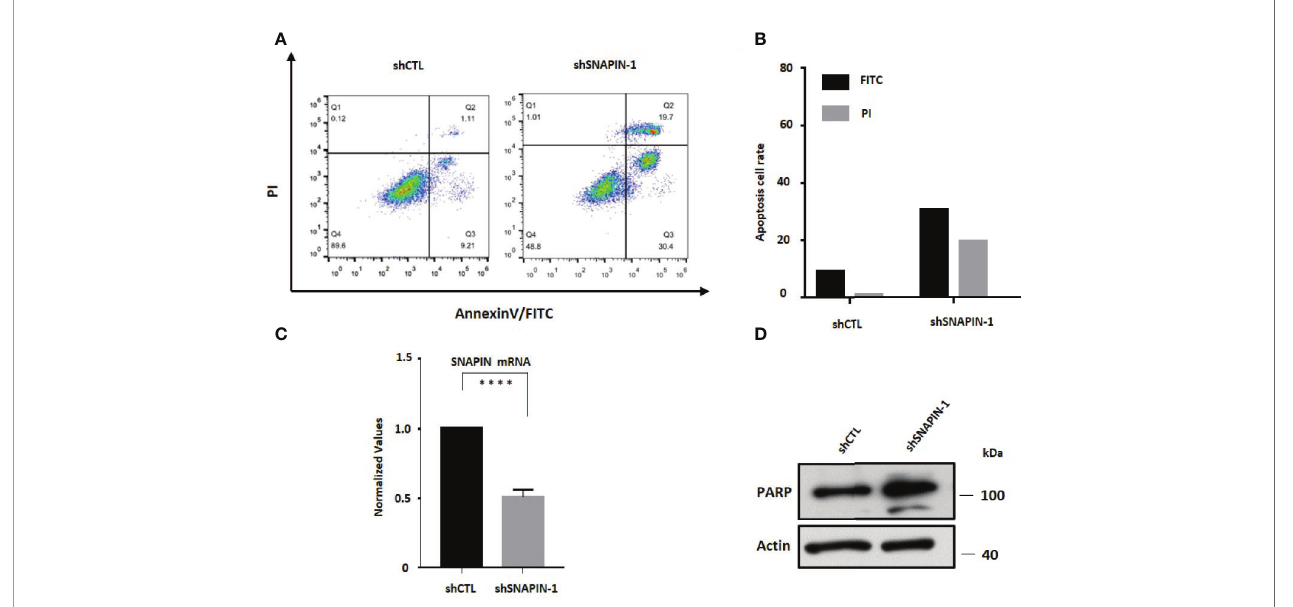
FIGURE 6 | SNAPIN knockdown induce apoptosis of b cells. (A) apoptosis assay indicate that the apoptosis of b cells were induced after SNAPIN knockdown. (B) statistic for FITC and PI of apoptotic b cells. (C) Mouse Min6 cells were transduced with lentivirus expressing shRNA and non-speci fi c sequences. A signi fi cant decrease in SNAPIN expression. (D) SNAPIN knockdown induced PARP cleavage of apoptotic marker protein. ****P <